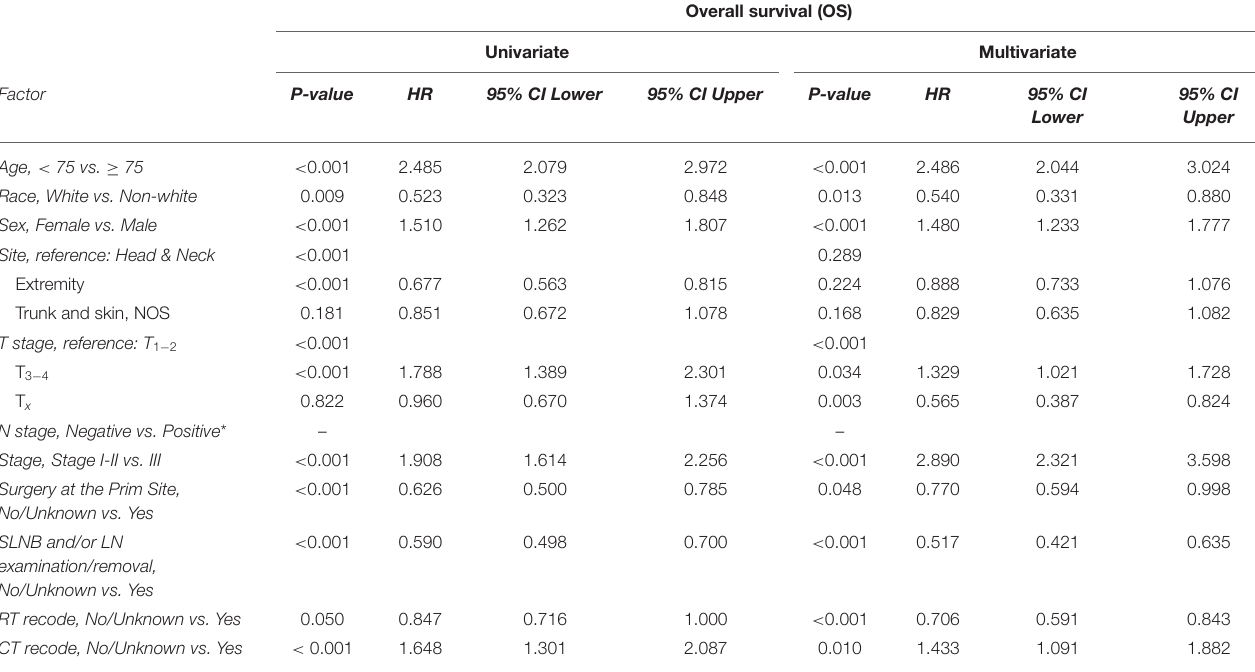
Overall survival (OS) Univariate